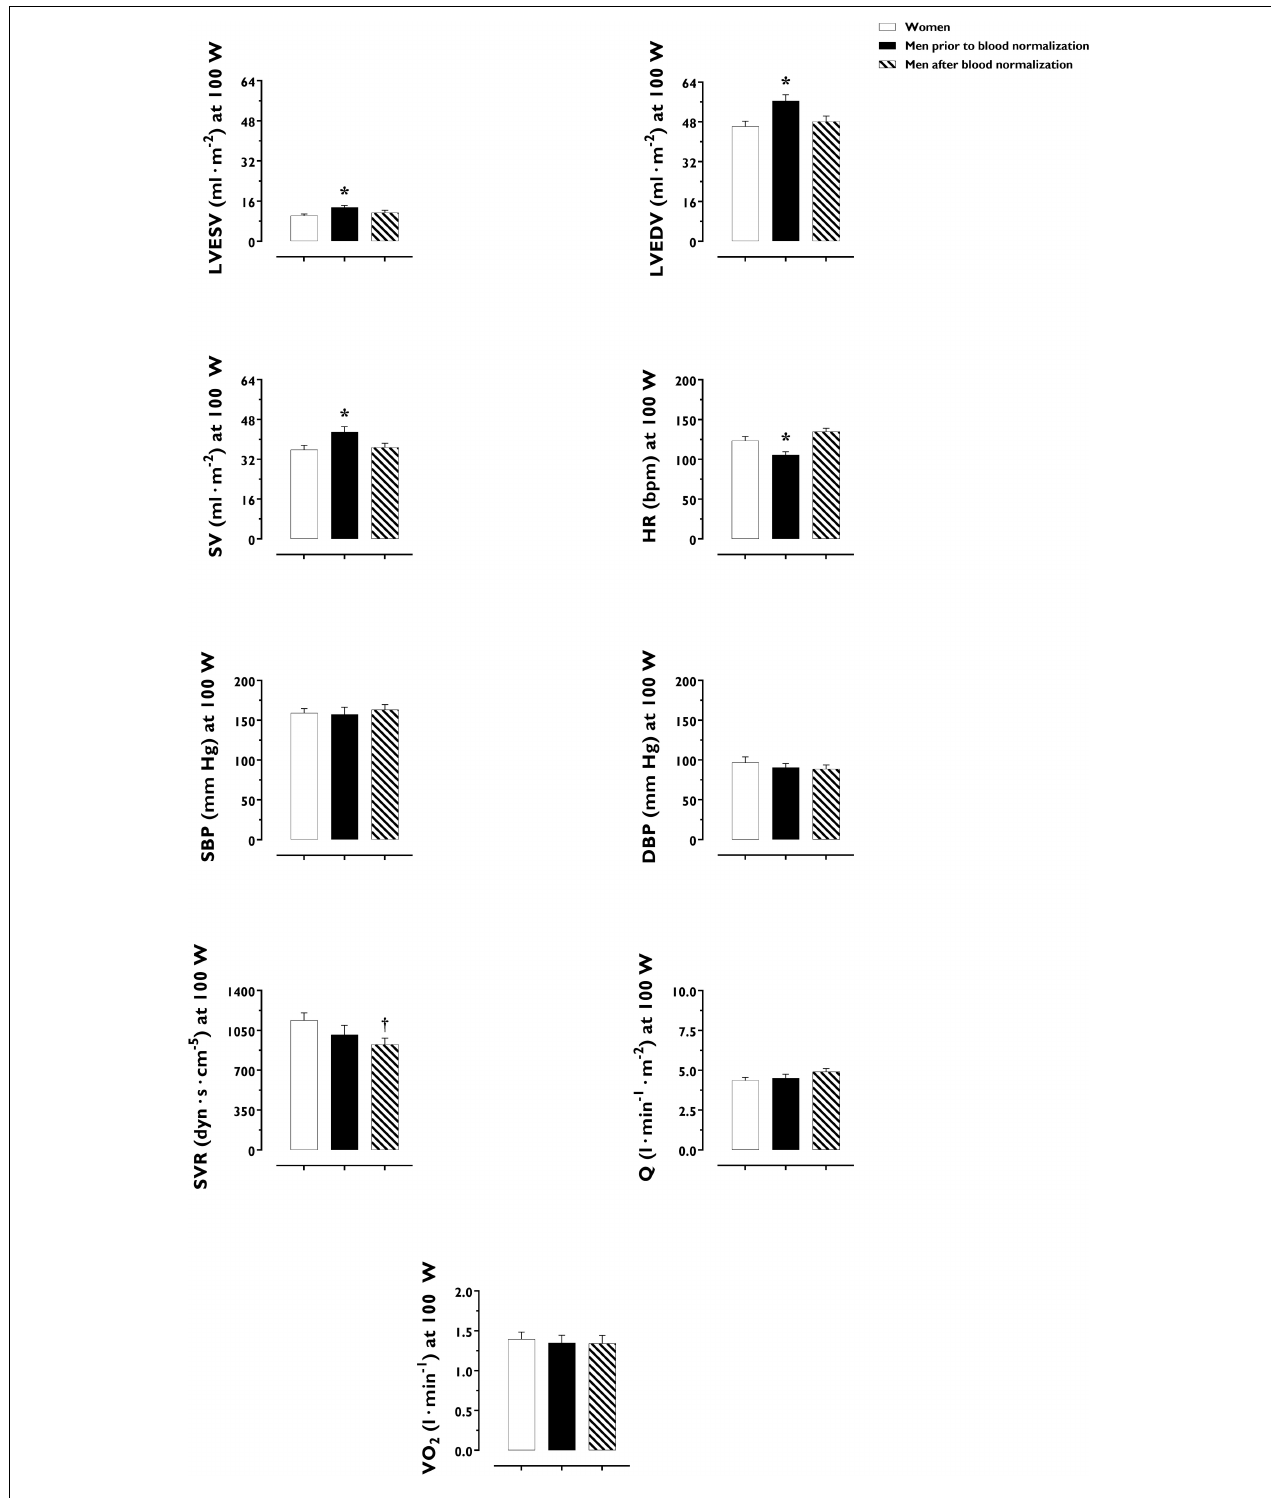
FIGURE 3 | Cardiac, hemodynamic and pulmonary variables at a given fixed submaximal exercise workload (100 W) in women and men prior to and after blood normalization. * P < 0.05 between women and men prior to blood normalization. † P < 0.05 between women and men after blood normalization. Data are expressed as mean ± SEM. Number of biological observations for each graph: LVEDV ( n = 42), LVESV ( n = 42), SV ( n = 42), HR ( n = 42), SBP ( n = 38), SVR ( n = 38), Q ( n = 42), VO 2 ( n = 35). HR, heart rate; LVEDV, left ventricular end-diastolic volume; LVEF, left ventricular ejection fraction; Q, cardiac output; SBP, systolic blood pressure; SV, stroke volume; SVR, systemic vascular resistance; VO 2 , oxygen uptake (per kg of body weight).